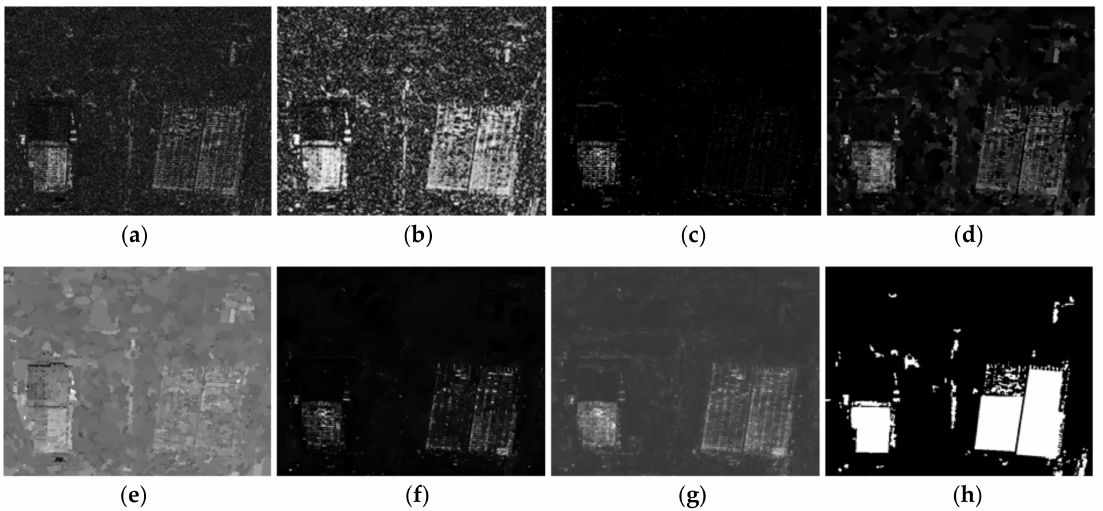
Figure 16. DIs of Wuhan SAR data set generated by different methods: ( a ) LR; ( b ) MR; ( c )